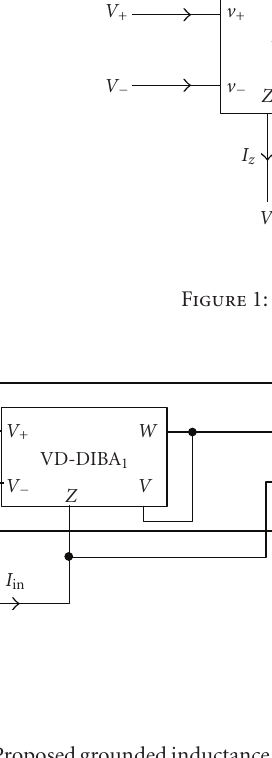
Figure 2: Proposed grounded inductance